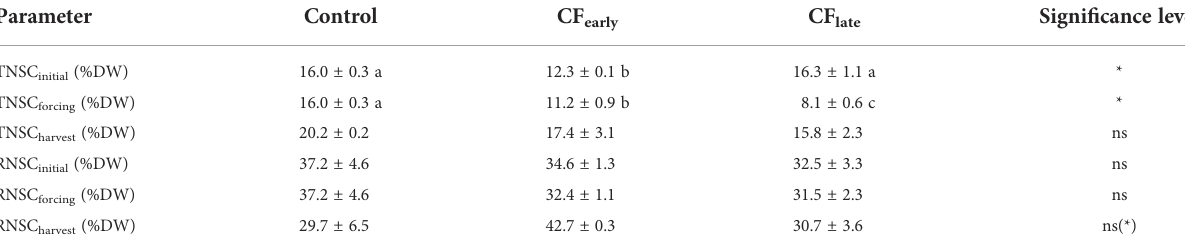
TABLE 5 Total non-structural carbohydrate concentration in trunk (TNSC) and roots (RNSC) at budburst (initial), forcing date (forcing) and at harvest (harvest) for Control and forced treatments in